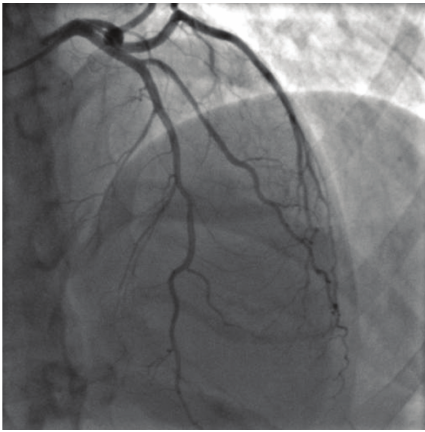
Figure 2: Final angiographic (35 ◦ LAO and 23 ◦ CRA) whereby nor- mal patency of the coronary arteries is